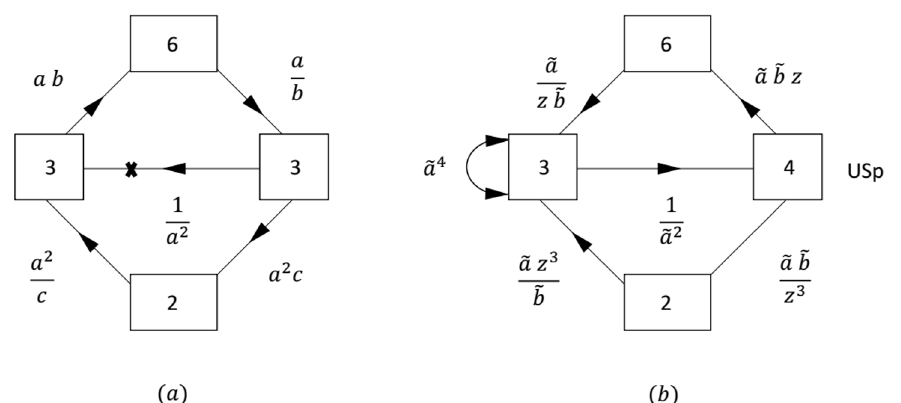
Figure 16 . Two theories associated with the compactification of the SU(2) × SO(16) 5 d SCFT on a tube with (a) two SU(3) punctures and (b) an SU(3) and a USp(4) puncture. Charges under the global symmetries are denoted using fugacities. In (b) we have also split the 8 chirals on the two sides to 6 + 2 , and correspondingly only the SU(6) × SU(2) × U(1) z subgroup of the SU(8) global symmetry is manifest in the quiver.